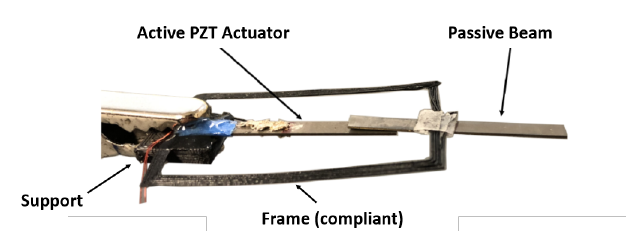
Figure 7. Photograph of the prototype impact-based amplification mechanism. The left is the active PZT actuator and the right is the rigid output beam on the compliant amplification